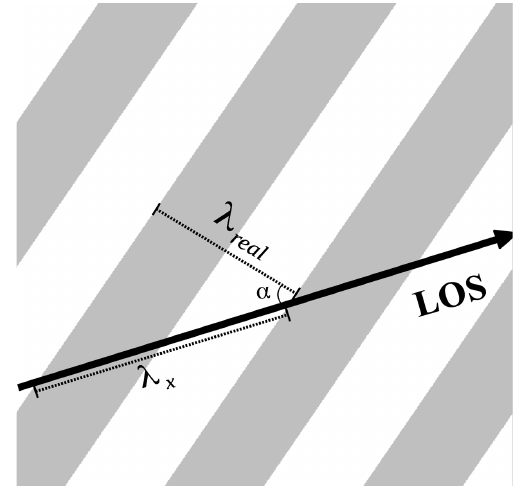
Figure 8. Viewing geometry between the satellite line of sight (LOS) and the horizontal wave vector. The wave fronts are repre- sented by the grey shading. The observed horizontal wavelength λ x and the real horizontal wavelength λ real are related by an angle α : λ real = λ x cos α .